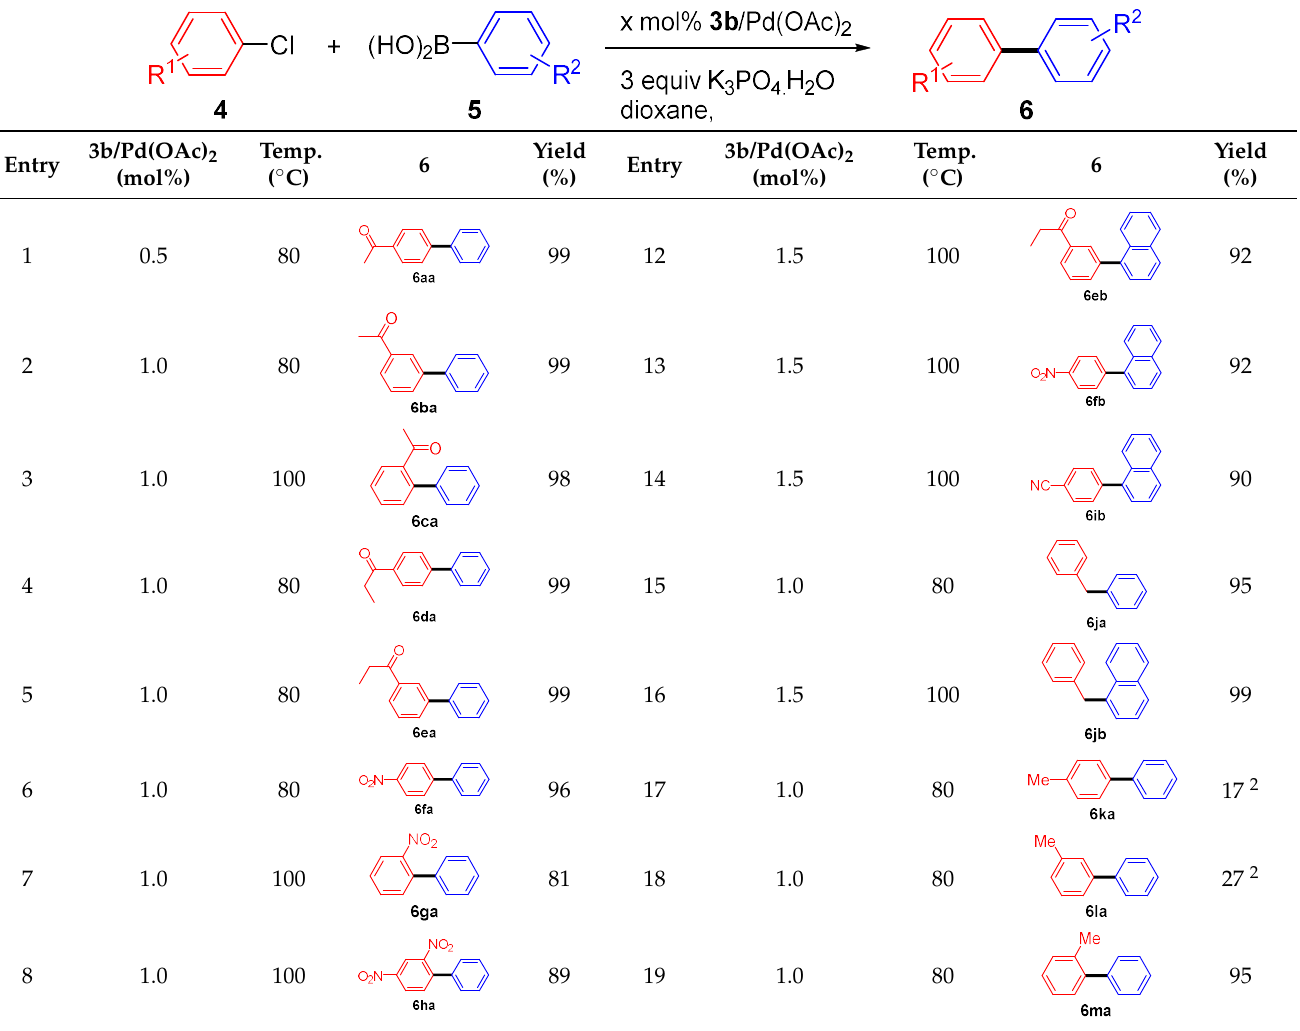
Table 3. In-situ-generated 3b/ Pd(OAc) 2 catalyst catalyzed Suzuki–Miyaura cross-coupling reactions 1 .